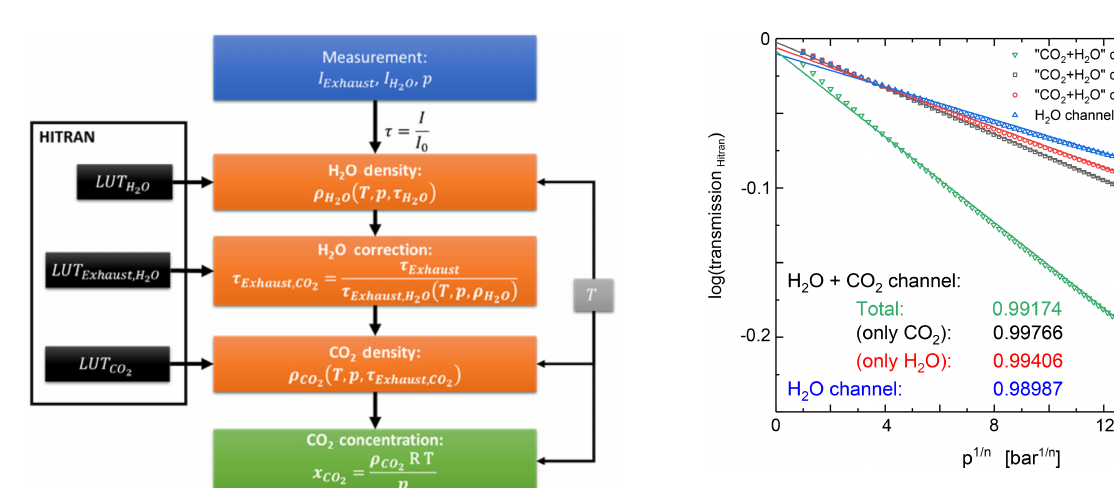
Figure 7. HITRAN simulation of the logarithmic transmission as 1 a function of p n for H 2 O and CO 2 absorption in the respective detection channels for a typical polytropic compression in an IC engine ( T 0 = 300K, p 0 = 1bar, n = 1 .